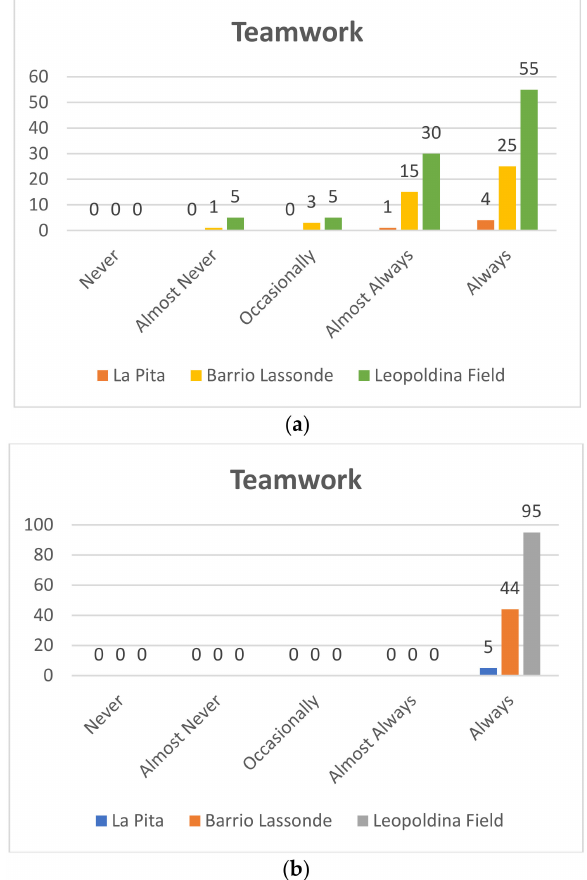
Figure 16. First grade teamwork: Pre-Test ( a ) and Post-Test ( b